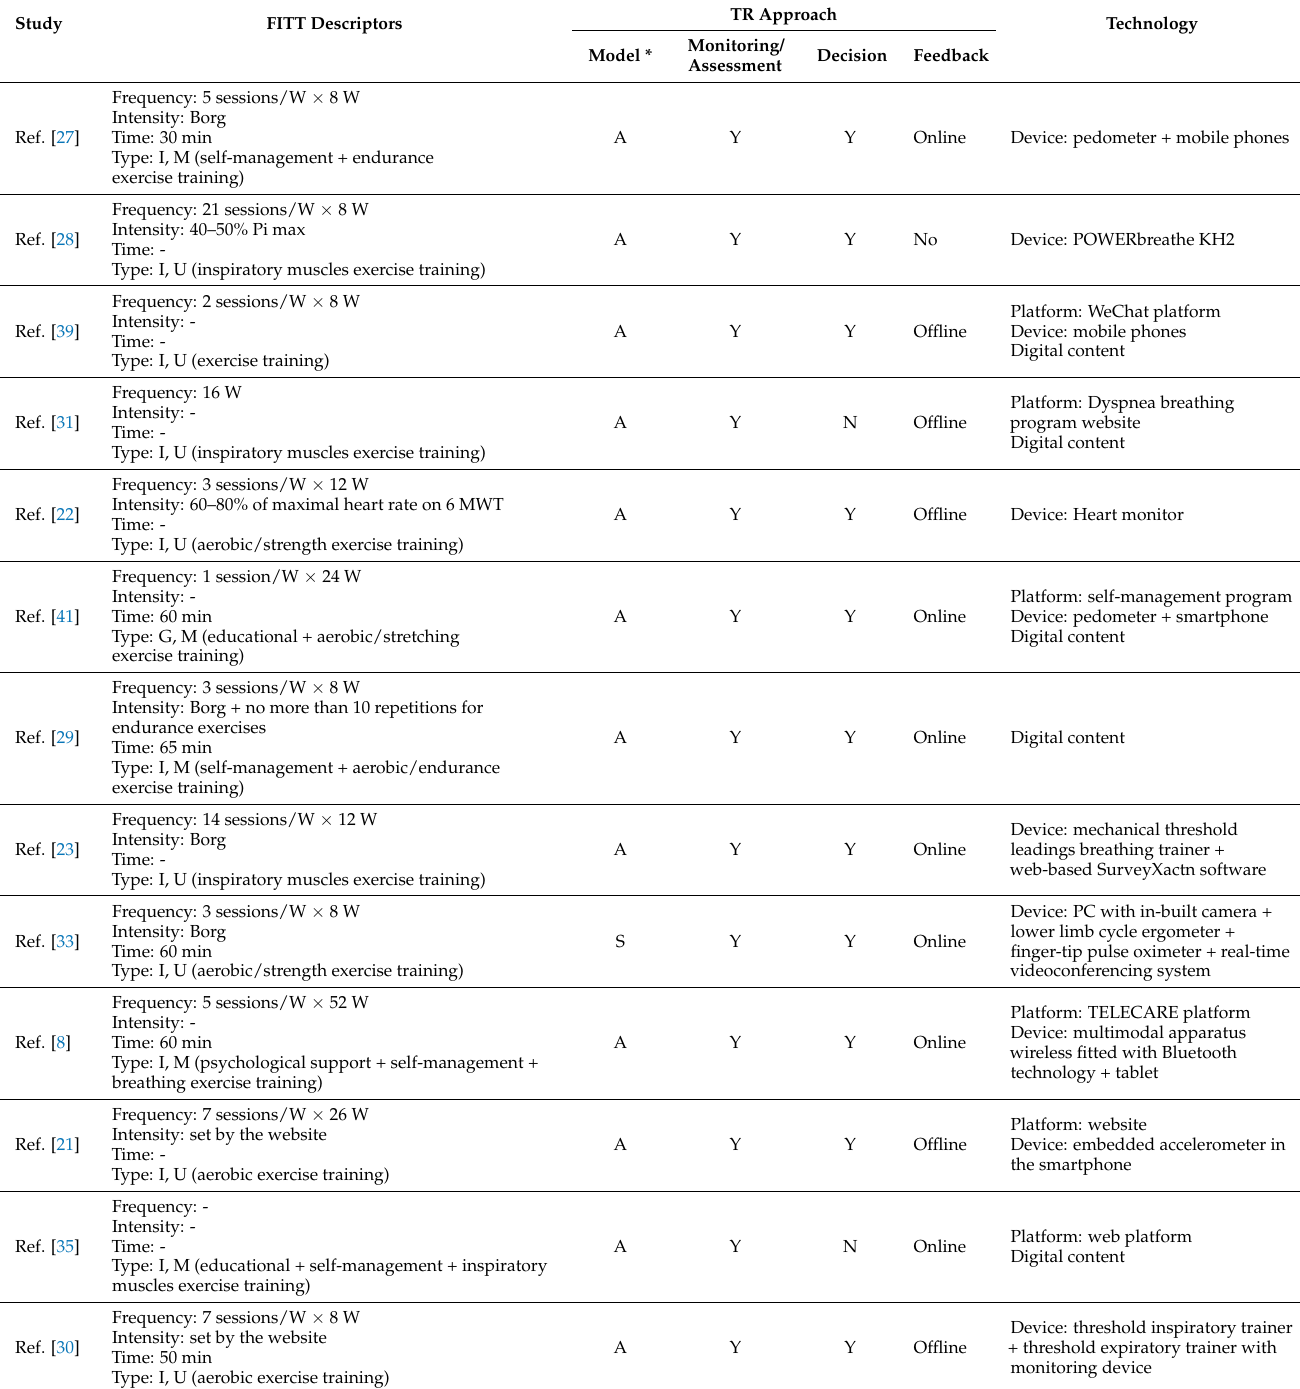
Device: threshold inspiratory trainer Offline + threshold expiratory trainer with monitoring